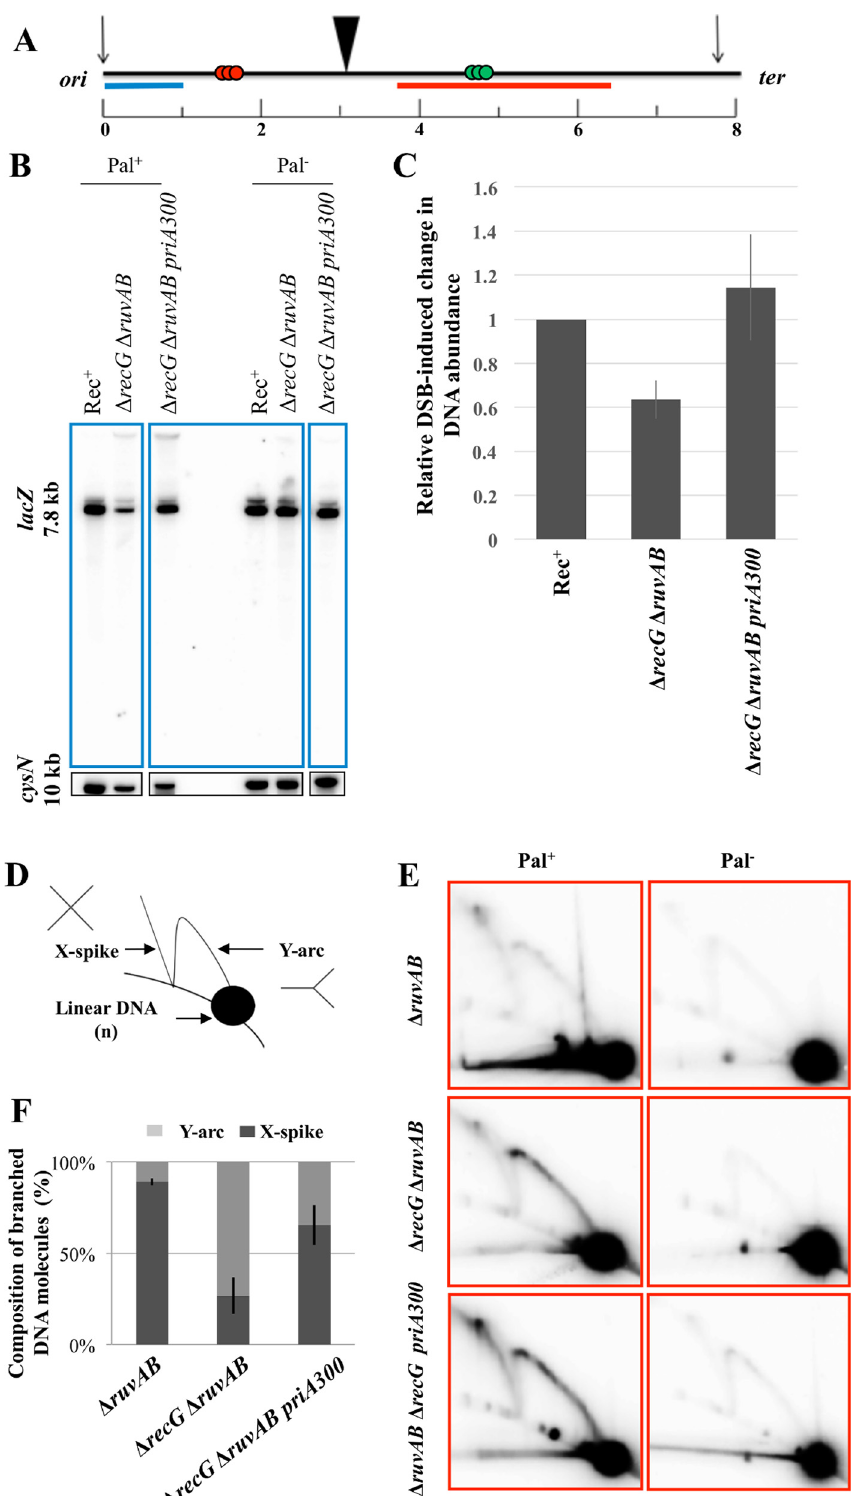
Fig 4. The priA300 mutation suppresses the loss of DNA around a DSB in the absence of RecG and RuvAB. A. NdeI digestion map of the region surrounding the palindrome locus. NdeI cutting sites and the distance between them are marked with black vertical arrows and numbers (in kb), respectively.